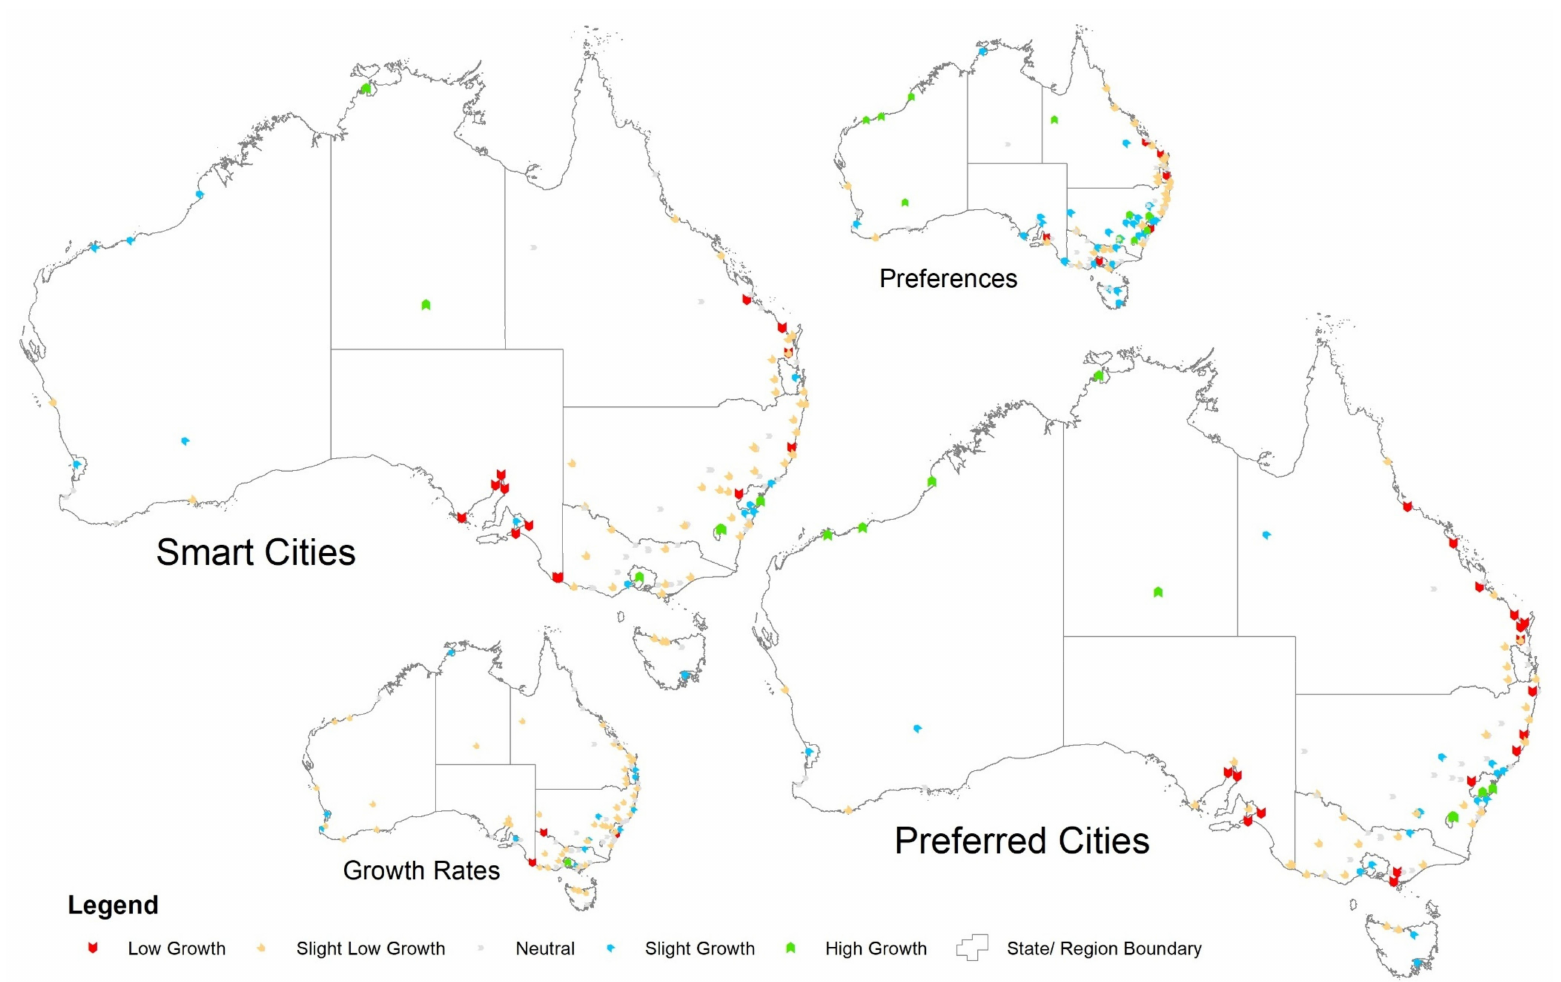
Figure 9. A spatial distribution of Smart Cities and Preferred Cities with the preference weightages and growth rates of last 10-years (Not to the